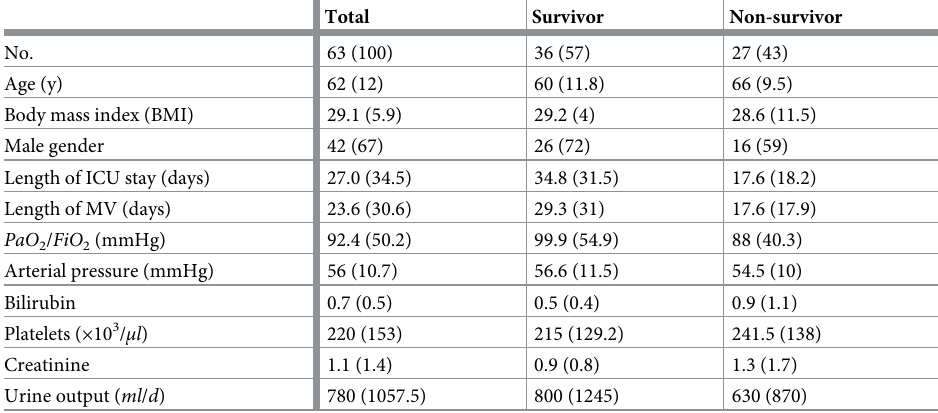
Table 1. Biometric and physiological parameters of the studied COVID-19 patients on the ICU admission. Values are represented as n (%) or median (interquartile-range).